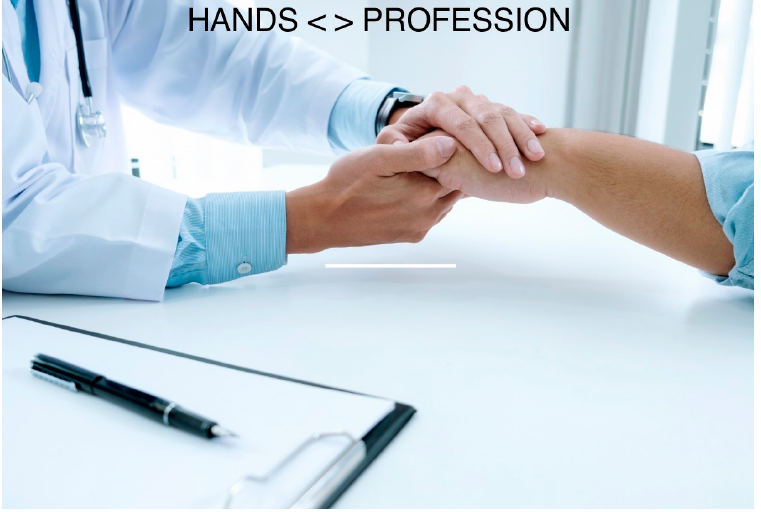
Figure 3. Third photovoice: relationship between ‘hands’ and ‘profession’.